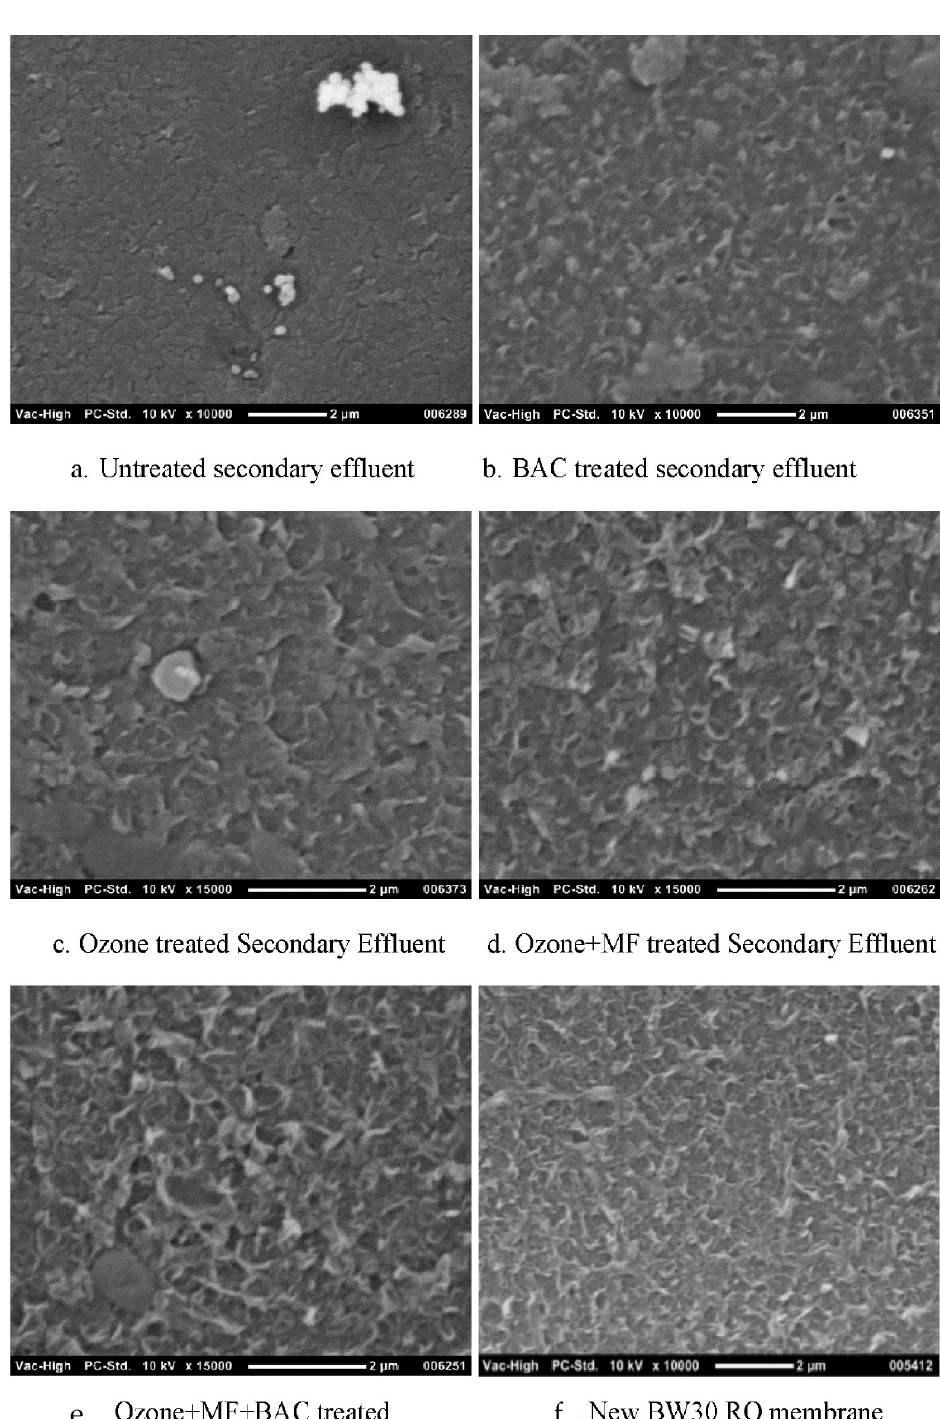
e. f Figure 5. The morphology of the membrane surface after filtration and permeate flushing [64]. Figure 5. The morphology of the membrane surface after filtration and permeate flushing [64]. An ozone + ceramic + BAC membrane provides the best protection for the RO mem- Direct osmosis is a common phenomenon in RO systems that treat high-salinity feed brane. Any foulant in the water after this pretreatment combination can be easily removed water. When a RO unit is turned off, permeate flows back through the membrane to the from the RO membrane surface with DI. If DI is used frequently for cleaning, chemical feed side. It is used in a novel cleaning technique known as direct osmosis–high cleaning may be reduced. Ozone combines with an MF ceramic membrane to effectively